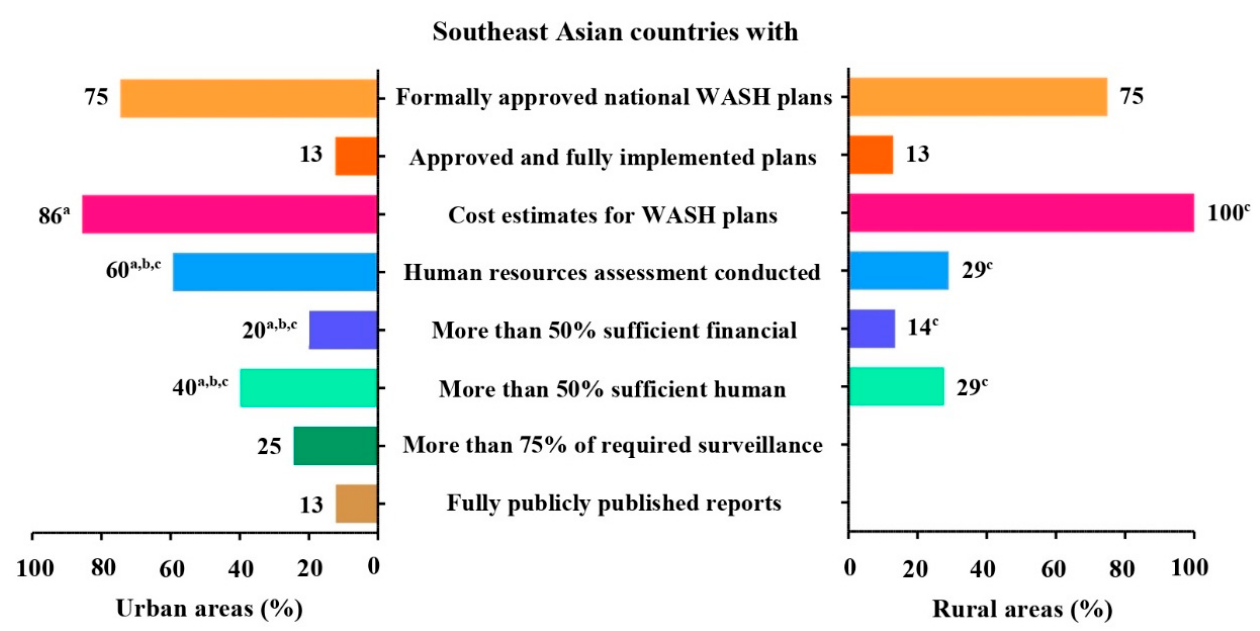
Figure 4. Percentage of Southeast Asian countries (excluding Brunei, Malaysia, and Singapore) with approved and implemented WASH plans, cost estimates, and human resource assessment conducted for those plans, more than 50% sufficient financial and human resources, more than 75% required frequency of surveillance in practice compared to the requirements and regulatory authorities publish publicly accessible reports on drinking water quality. a—without data from Cambodia; b—without data from Myanmar; c—without data from Vietnam. [dataset] WHO. 2019. UN-Water global analysis and assessment of sanitation and drinking-water (GLAAS) 2019 report.